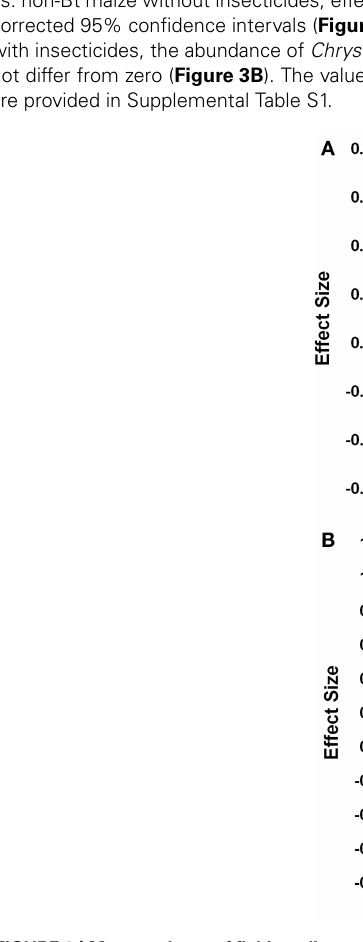
maize fields compared with conventional maize (see Steps 6 and 7